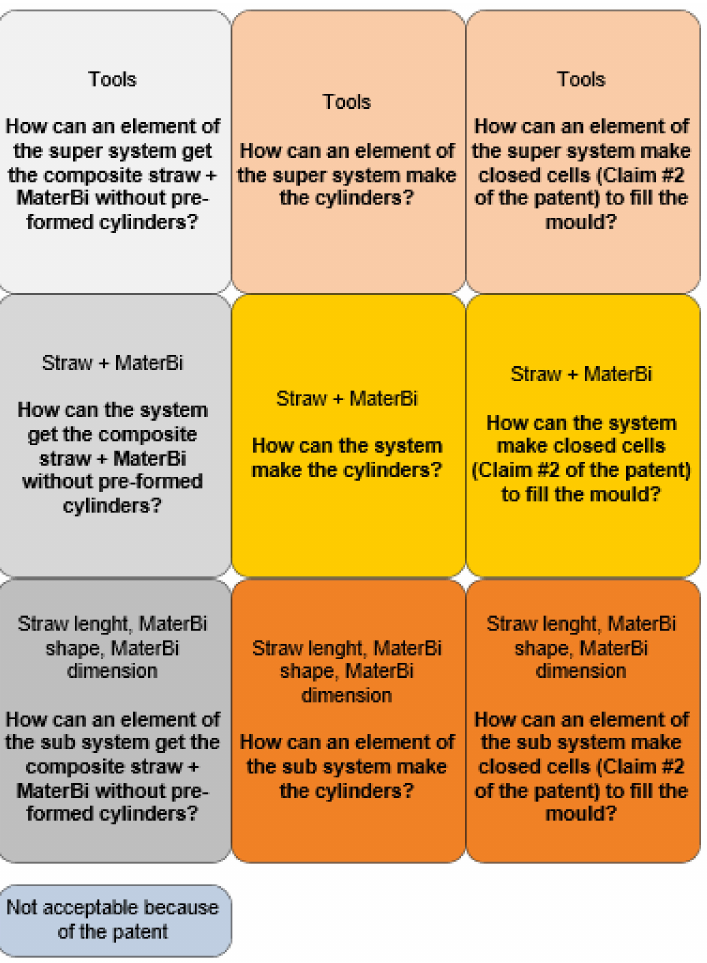
Figure 6. The first SO built for the case study by following the proposed alternative